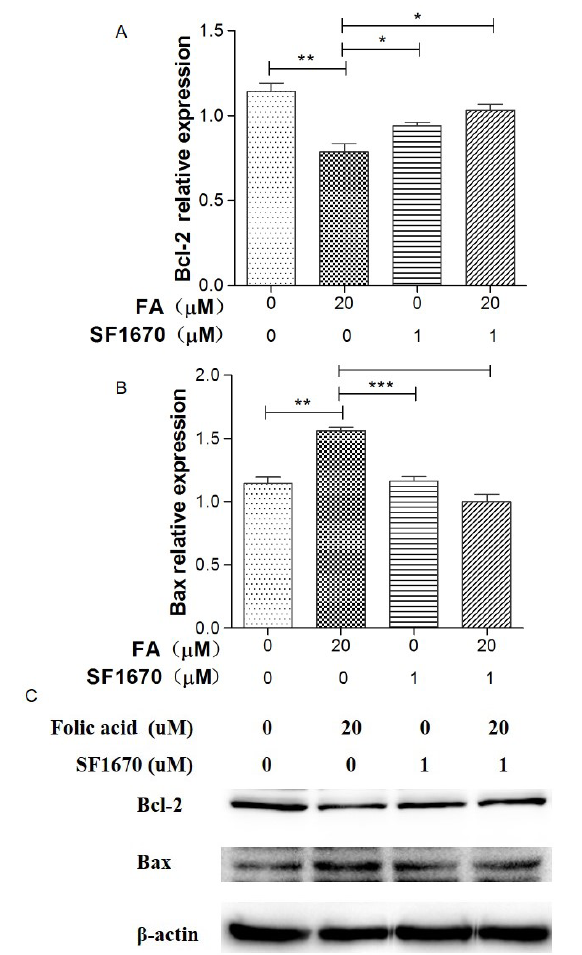
Figure 3: SF1670 inhibits the up-regulated expression of Bax and down-regulated expression of Bcl-2 by folic acid in MDA-MB-231 cells. After pre-treatment of MDA-MB-231 cells with 1 μM SF1670 for 2 h, the cells were supplemented with 20 μM folic acid for 24 h, and the protein expression levels of Bcl-2 and Bax were detected by Western blot. β-Actin was used as an internal